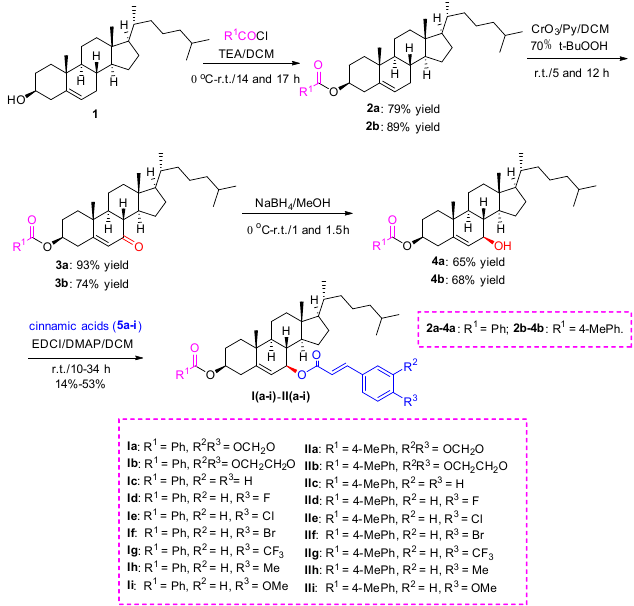
Scheme 1. Synthesis of target compounds I ( a–i ) − II ( a–i